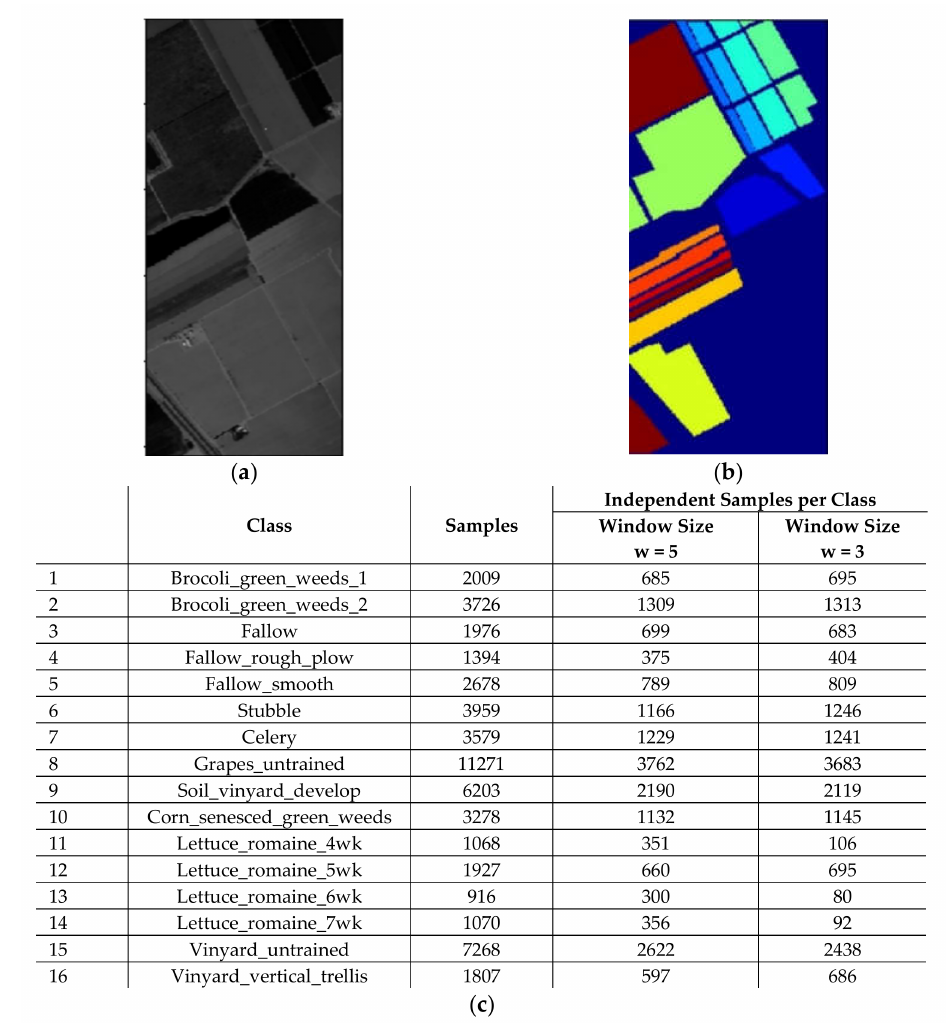
Figure 10. Hyperspectral remote sensing scenes for the Salinas dataset: ( a ) sample band of the Salinas dataset, ( b ) reference map of the Salinas dataset, ( c ) reference map classes for the Salinas scene and their respective samples